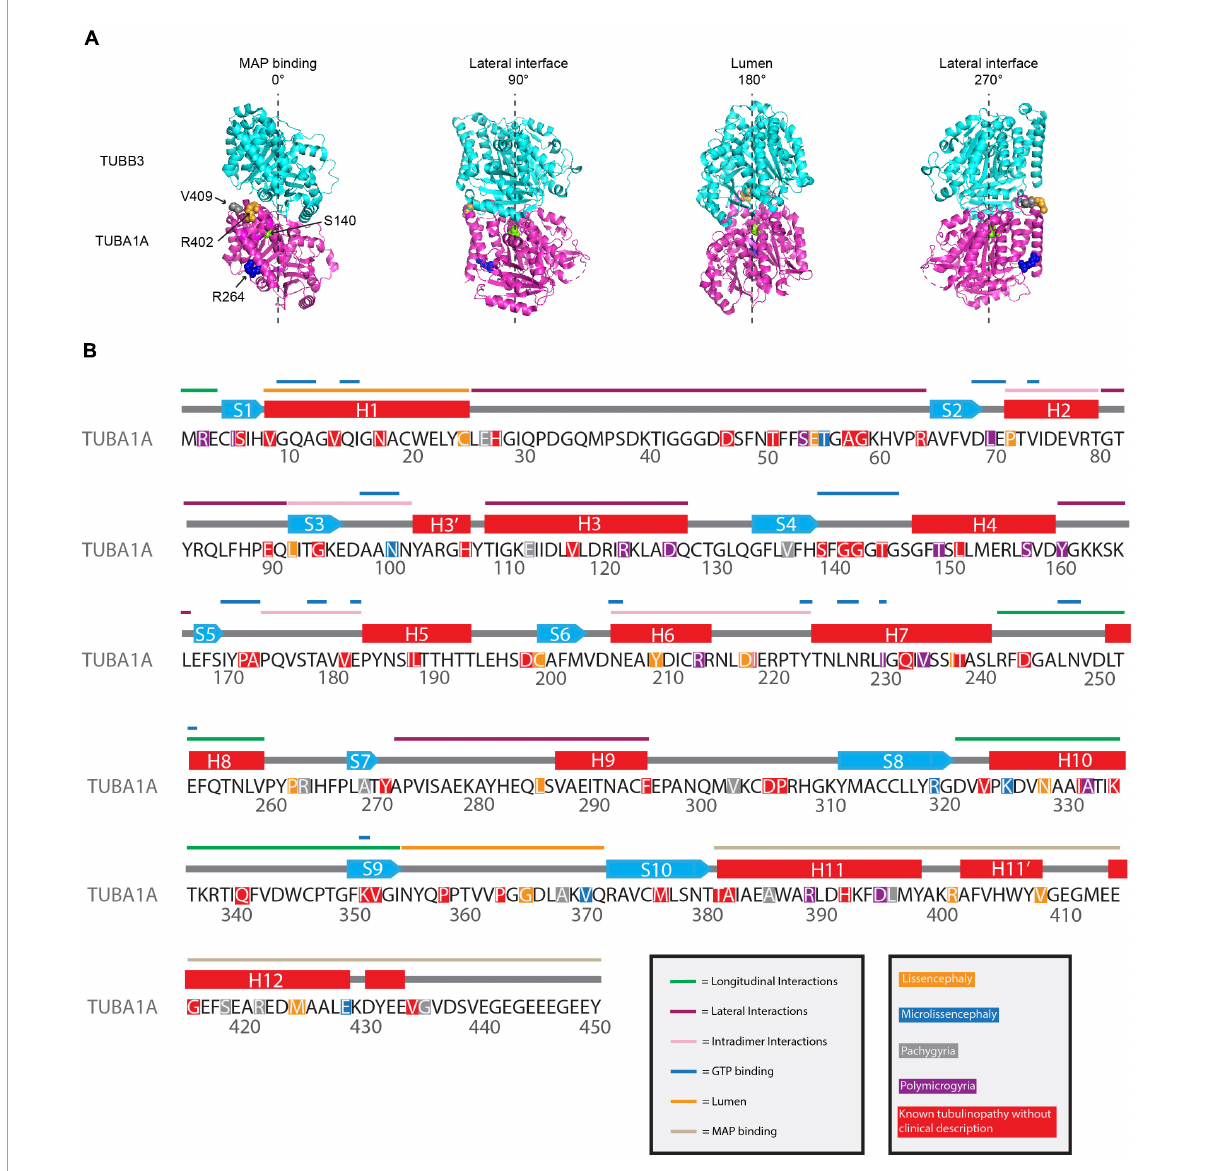
FIGURE3 Mapping TUBA1A tubulinopathy mutations. (A) Mapping individual mutants described in section “Investigating specific residues affected by mutations in patients; can they tell us more about the etiology of tubulinopathies?” on TUBA1A (PDB structure: 5JCO). α -tubulin is human TUBA1A in magenta and β -tubulin is human TUBB3 in cyan. Spheres represent TUBA1A residues S140 (green), R264 (blue), R402 (orange), and V409 (gray). Four views of the structure are shown, each rotated 90 ◦ along the longitudinal axis. The 0 ◦ angle represents the outer surface of the microtubule that is considered the MAP binding region. 90 ◦ and 270 ◦ angles represent lateral interfaces with adjacent protofilaments. 180 ◦ represents the luminal side of the microtubule. (B) Known TUBA1A mutations to date mapped on primary sequence according to predominant cortical malformation. If no clinical imaging data is available to us, the mutation is highlighted in red. Functional regions described in section “Mapping the tubulinopathy mutations” are labeled in various colors above the secondary